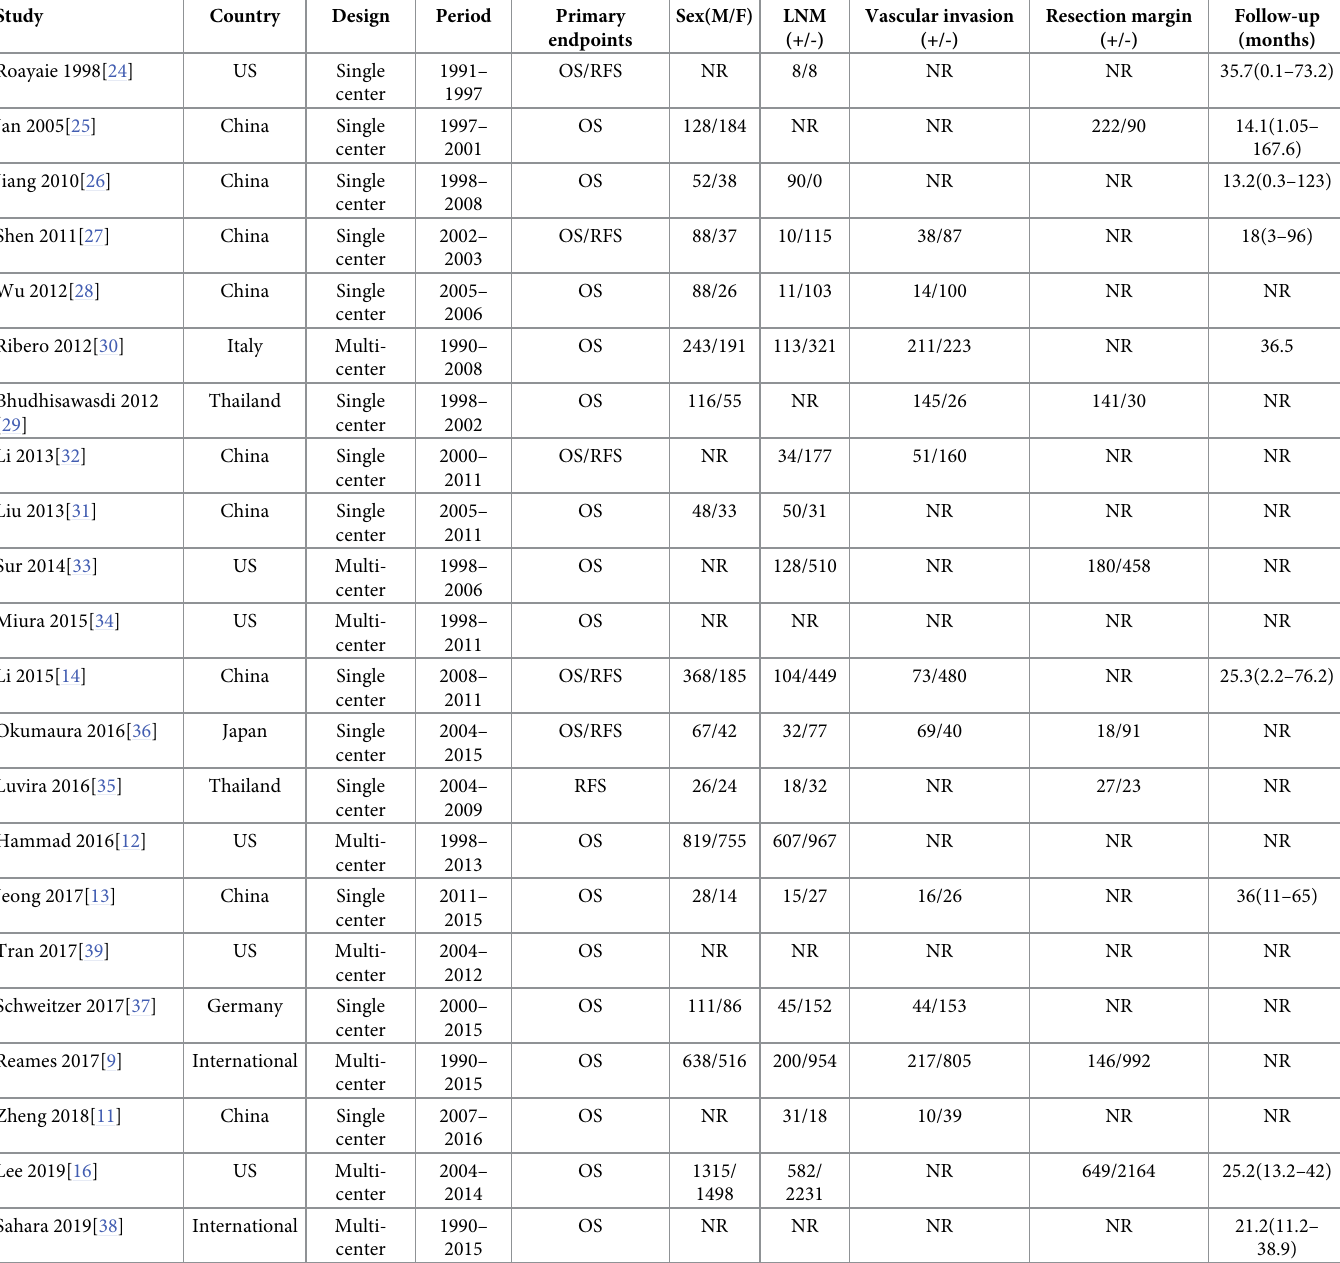
Table 1. Basic characteristics of included